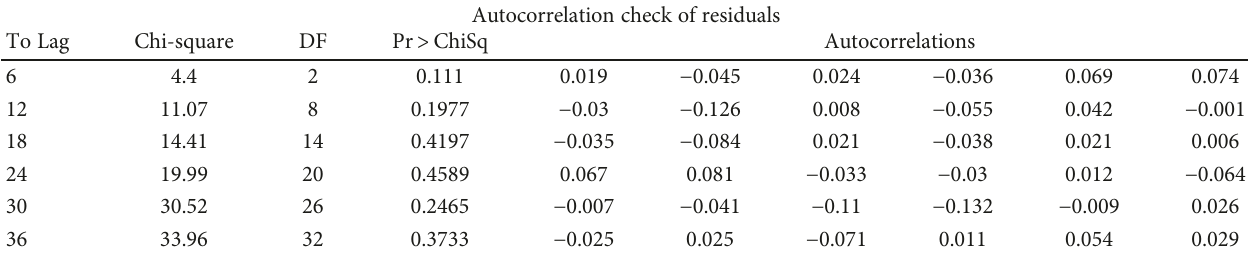
Table 7: Ljung-Box test results for ARIMA modeling of wheat prices.